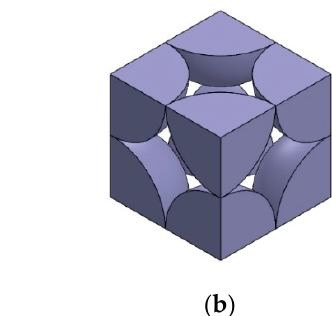
Figure 3. BCC with spheres. ( a ) Position of the centers of spheres; ( b ) Structure.